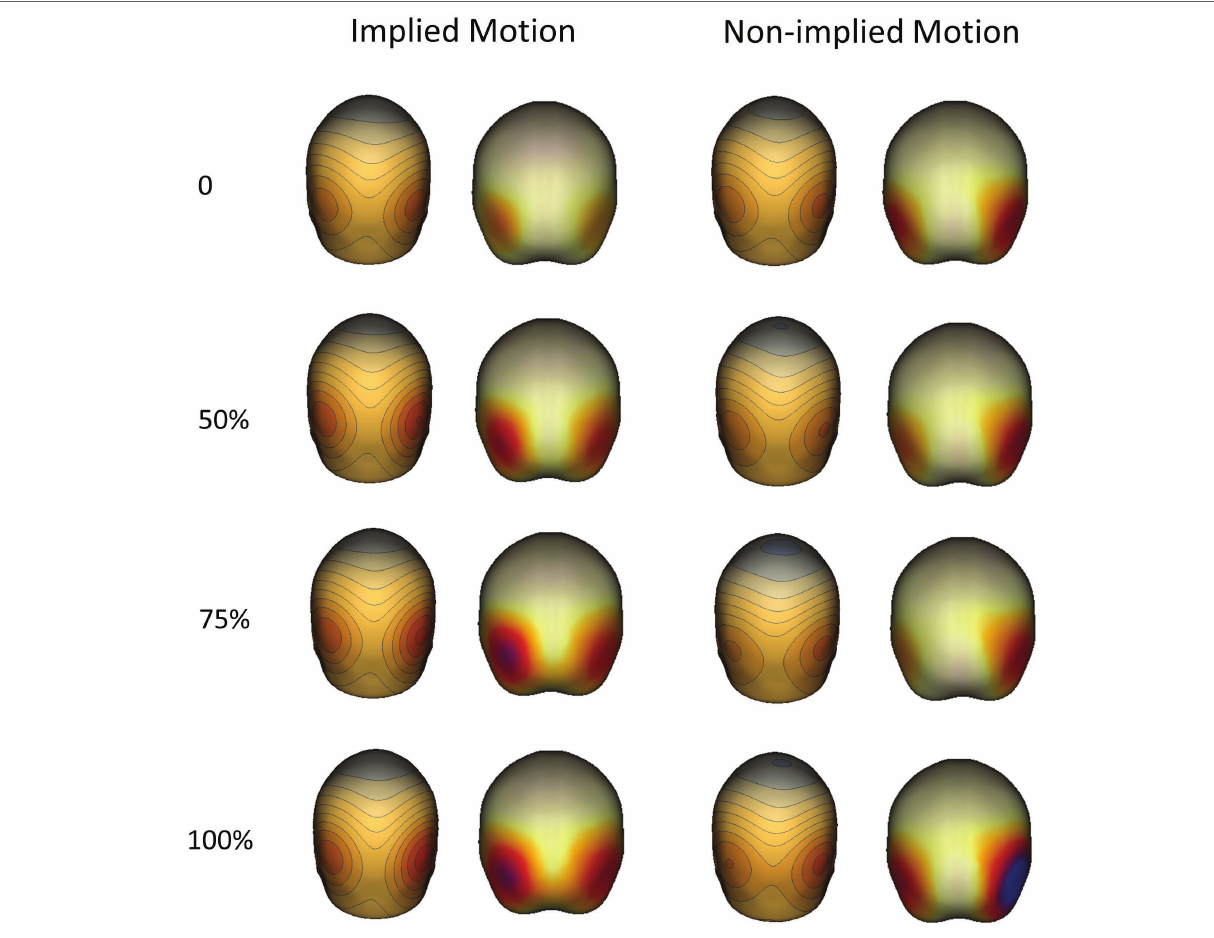
FIGURE 4 | Topographical maps (right) and sources (left) of P2 components evoked by implied motion (IM) and non-implied motion (non-IM) images of humans at different coherence levels. Localization analyses indicated that bilateral hMT+ regions were associated with P2 activity.